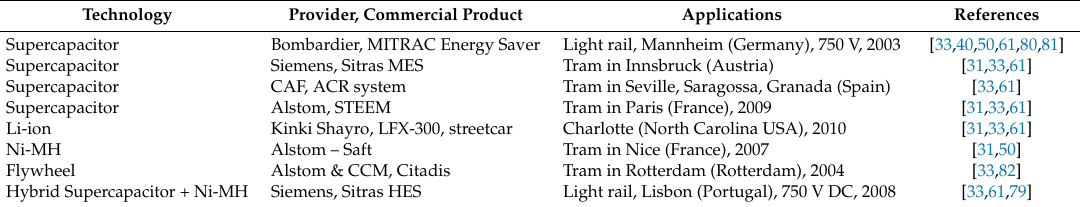
Table 1. Examples of onboard energy storage system (ESS) implementation.